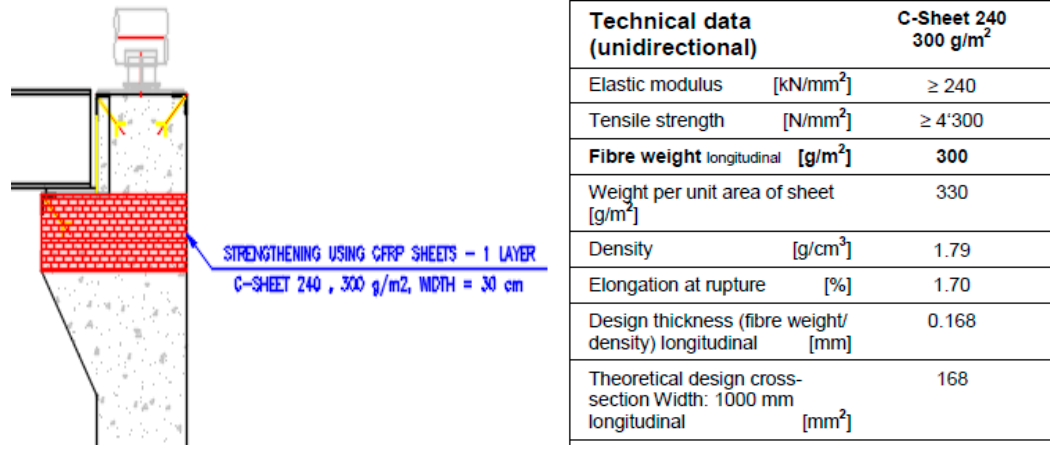
Figure 9. Proposed strengthening for the damaged reinforced concrete corbel and properties of the CFRP sheets selected.